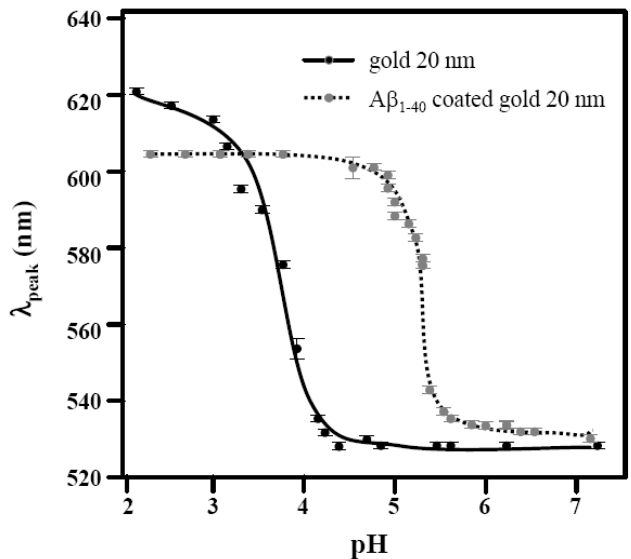
Figure 4. The peak position of the absorption spectrum in the region between 400 nm and 800